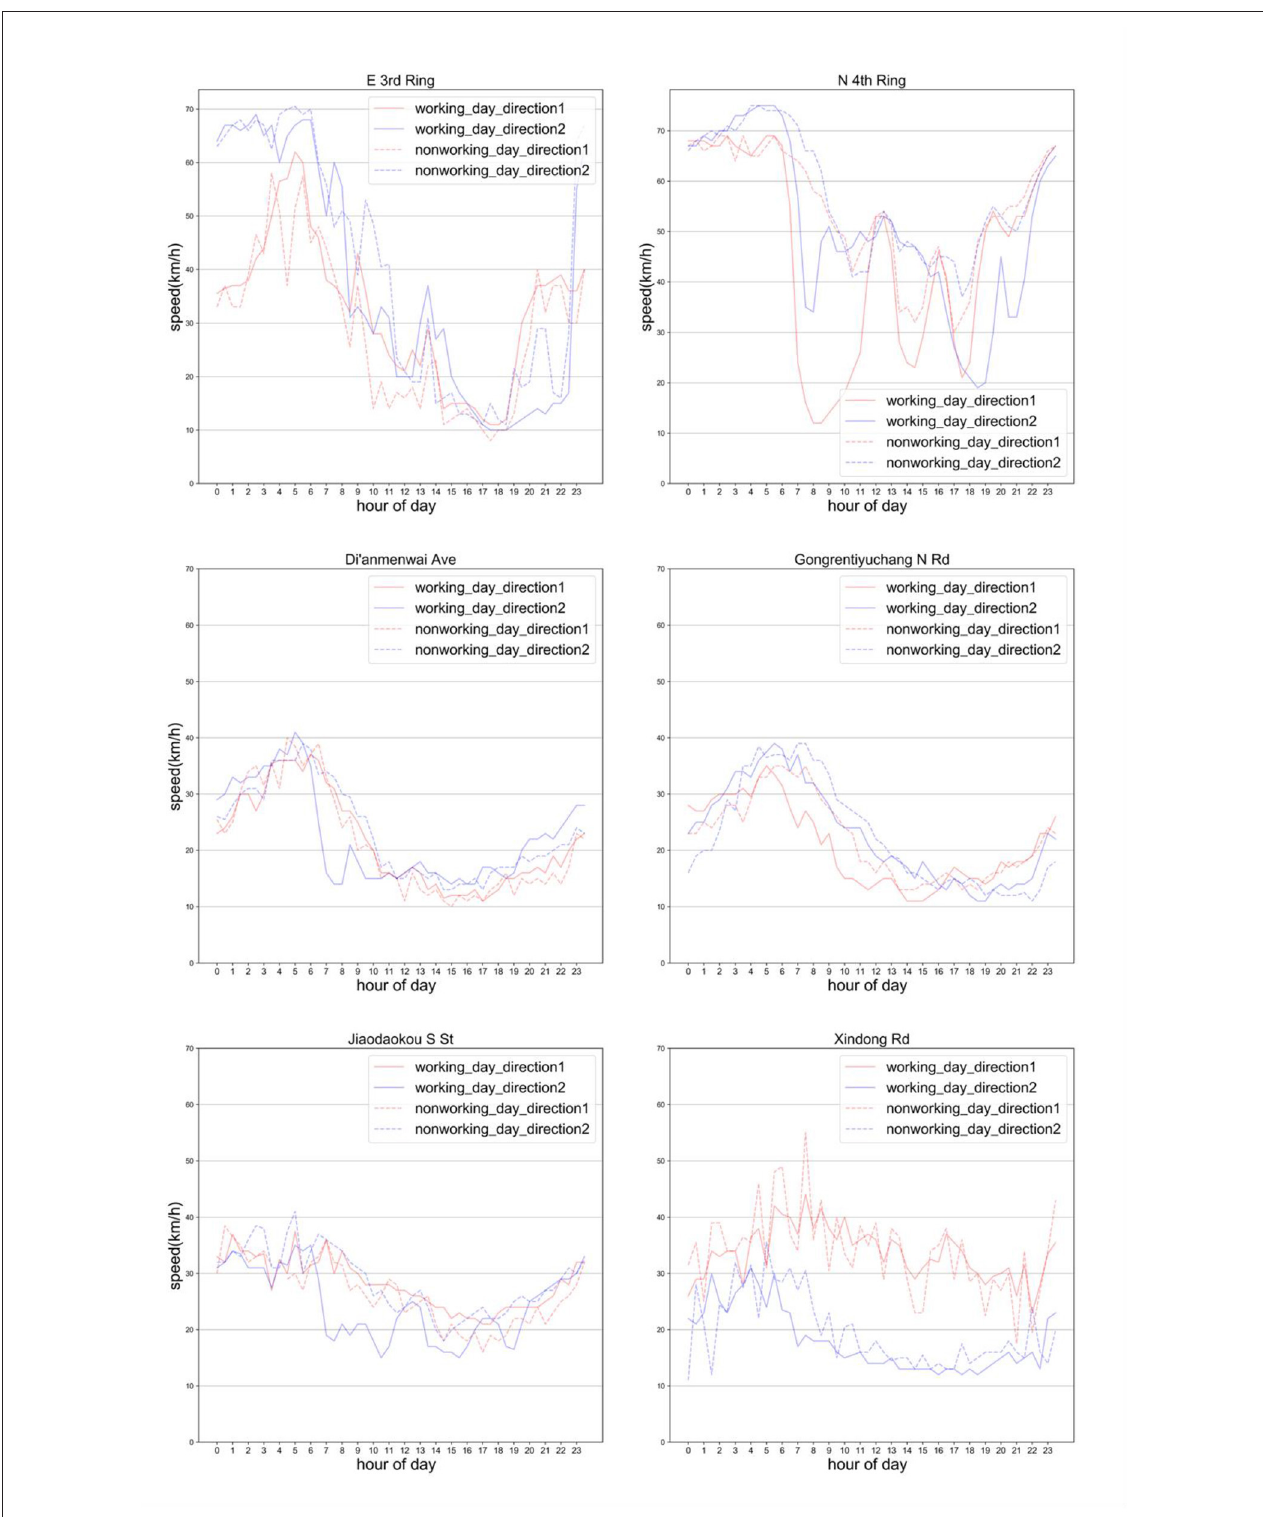
FIGURE 8 | Median speed values for some typical roads in four regions.